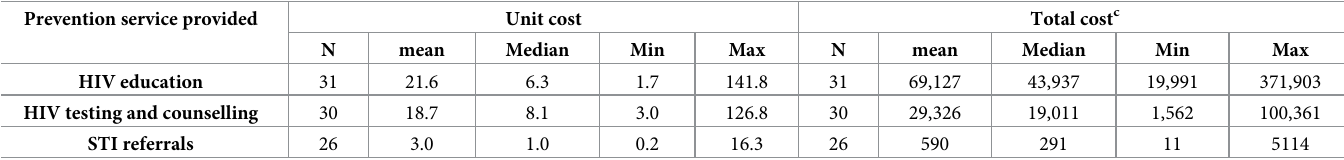
Table 2. Costs of HIV prevention services in Nigeria in 2016 a,b